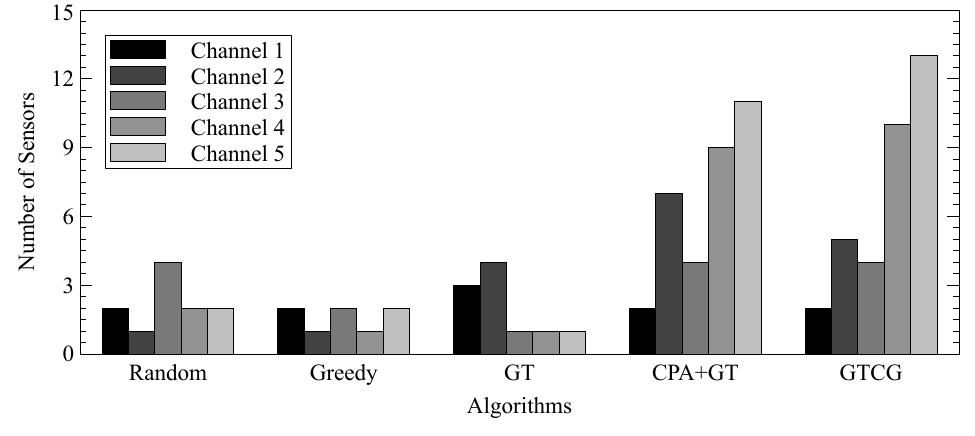
Figure 8. The Number of WSDs in Each Channel.